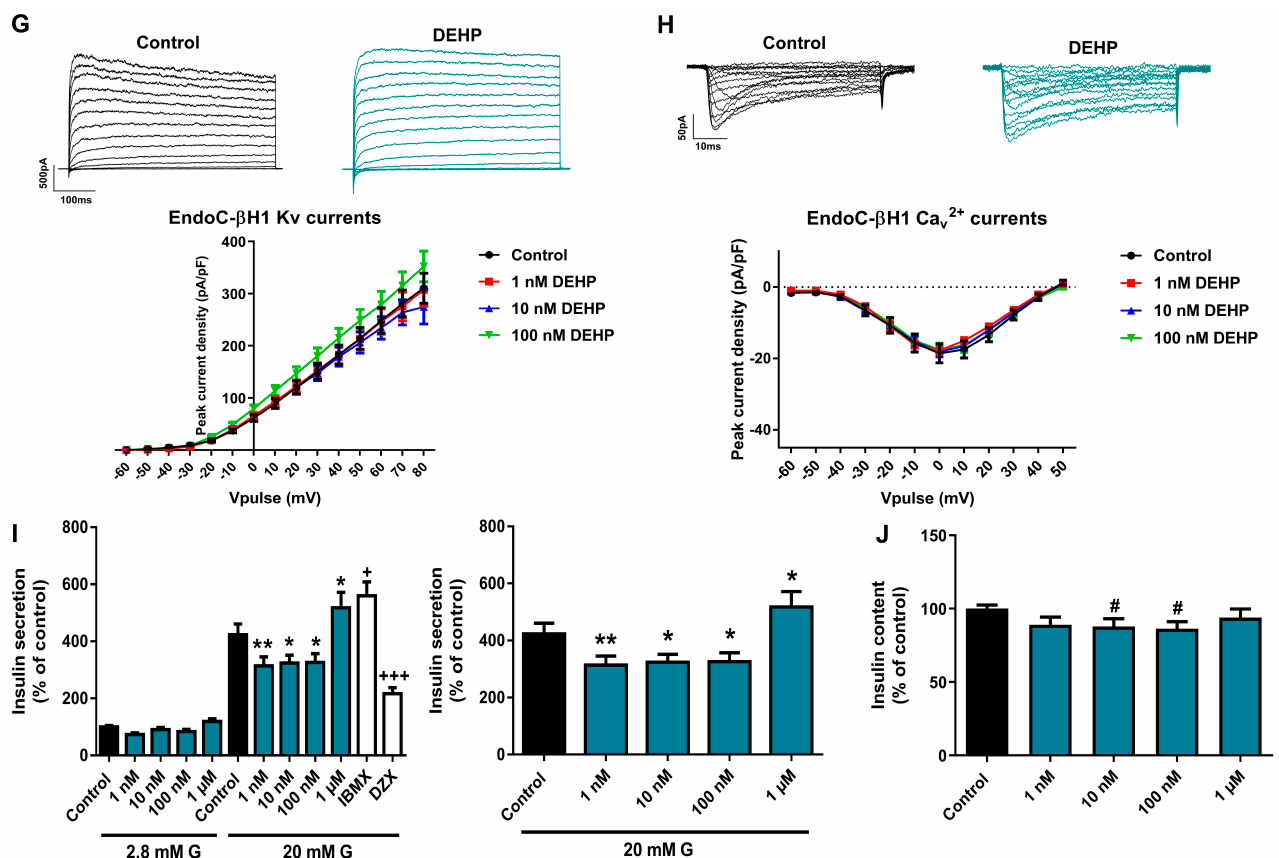
Figure 3. DEHP effects on pancreatic β -cells. ( A ) Viability of MIN6 cells treated for 24 h